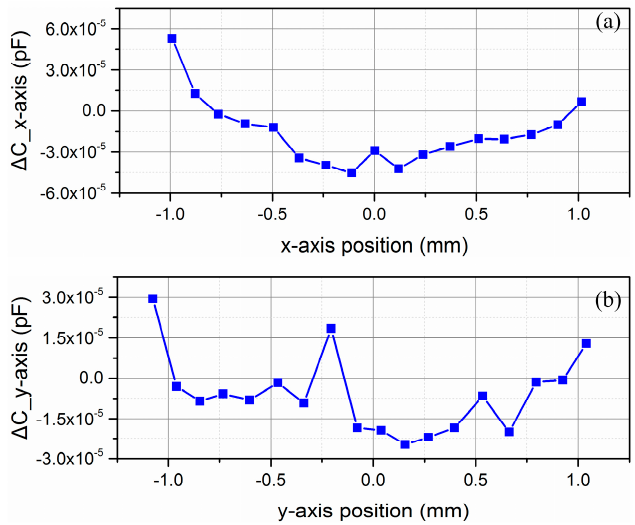
Figure 9. Experimental results of differential capacitance value along x and y axes. ( a ) Experimental result over the range of ±1 mm along the x-axis; ( b ) Experimental result over the range of ±1 mm along the y-axis.